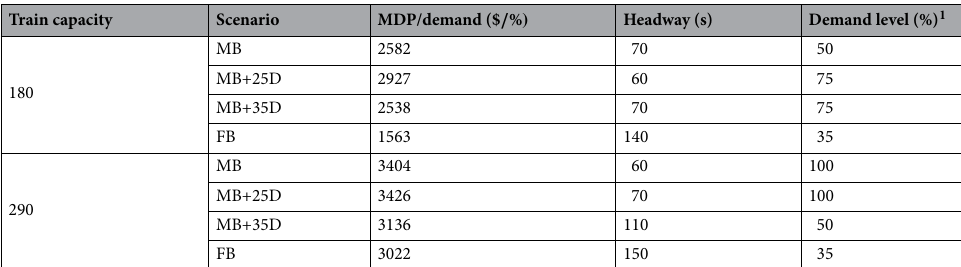
Table 3. Performance normalised by demand - best performing headway value for each operating scheme for baseline crowding multiplier of 1. MB base moving block, MB+25D moving block with 25 s minimum dwell time, MB+35D moving block with 35 s minimum dwell time, FB fixed block 1 Demand is reported as a percentage of 2019 demand